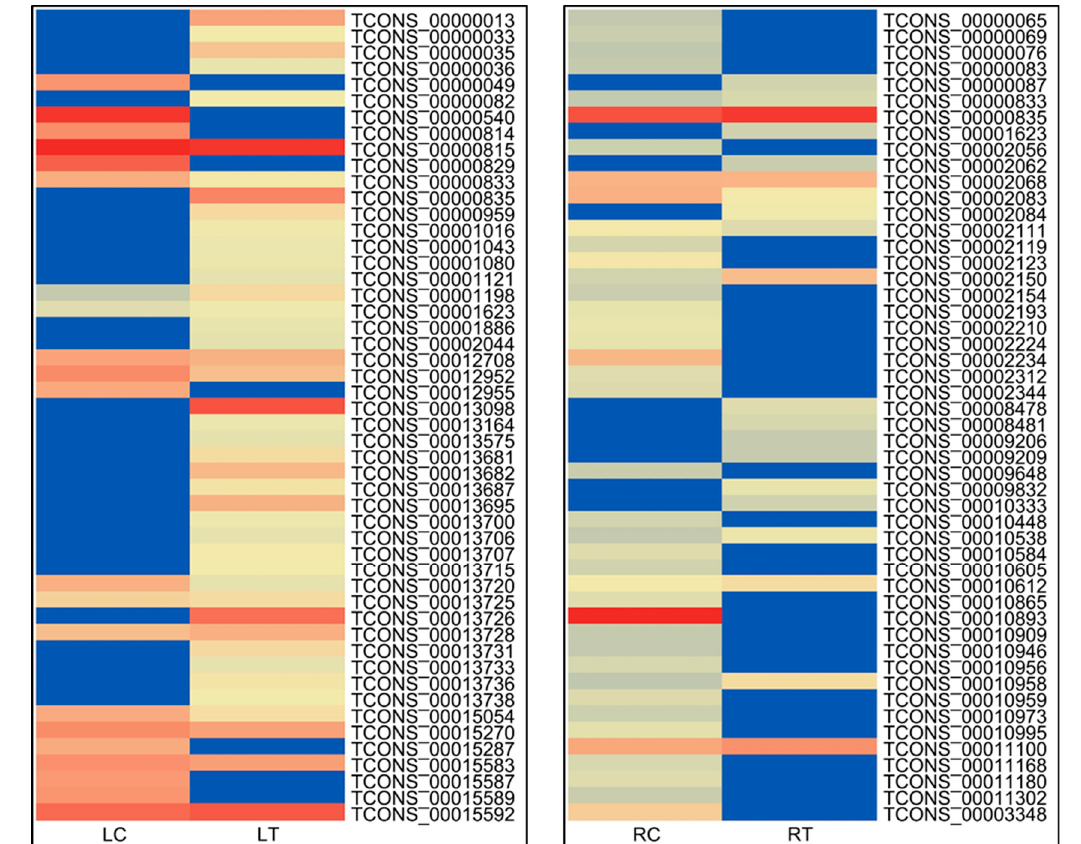
Figure 5. Heat map of the differentially expressed lncRNAs under LC:LT and RC: RT. To test if these lncRNAs could regulate the expression of protein-coding genes as long molecules, lncRNAs were tested for homology to CDS sequences by BLAST with >87% percent identity and >83% query coverage. The result shows that one lncRNA could pair with eight CDS sequences with a very good match, which suggests that this one lncRNA might regulate the expression of eight proteins by inducing transcriptional or post-transcriptional gene silencing. The detailed information of these lncRNAs when mapped with the CDS sequences of pearl millet is presented in Table 3. Table 3. Blast result of lncRNAs with the CDS sequences of pearl millet.